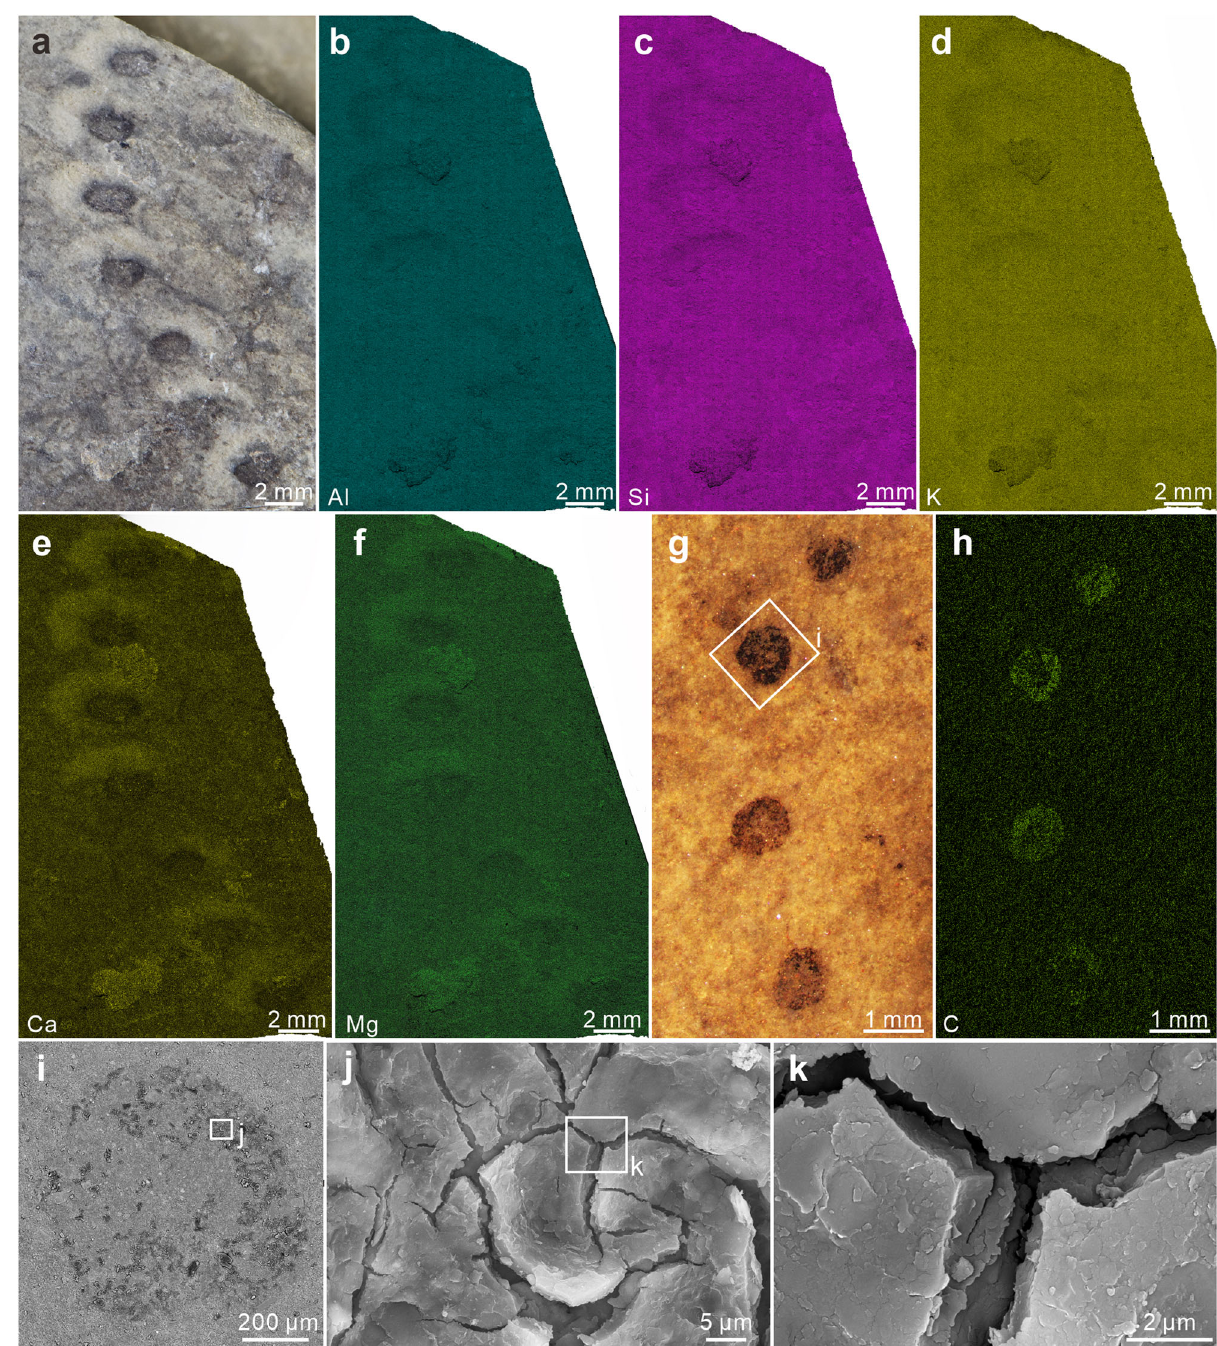
Fig. 4 RLM images, EDS elemental maps, and SEM images of Horodyskia moniliformis from the Tonian Shiwangzhuang Formation. a – f RLM image ( a ) and EDS elemental maps ( b – f ; element labeled in lower left) of a specimen with halos; halos are enriched in calcium ( e ) and magnesium ( f ), and slightly depleted in aluminum ( b ), silicon ( c ), and potassium ( d ) relative to matrix and beads; SWZ-CZ-25. g , h RLM image ( g ), EDS elemental map ( h ; element labeled in lower left), and SEM ( i , BSE; j , k , SE) images of a specimen without a preserved halo; beads are enriched in carbon (h); SWZ-CZ-42. i BSE image of box area in g , showing carbonaceous fi lm of the bead. j SE image of box area in i , showing multiple cracks in carbonaceous fi lm. k Magni fi cation of box area in j , showing carbonaceous fi lm which is a few microns in